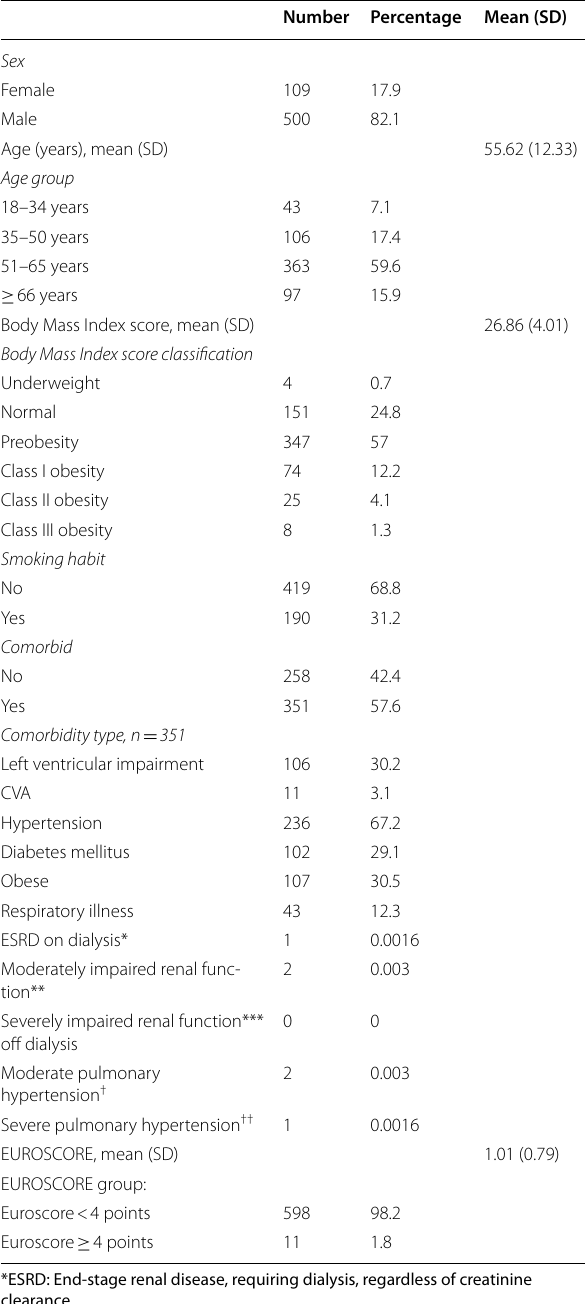
Table 1 Patients’ sociodemographic and past medical